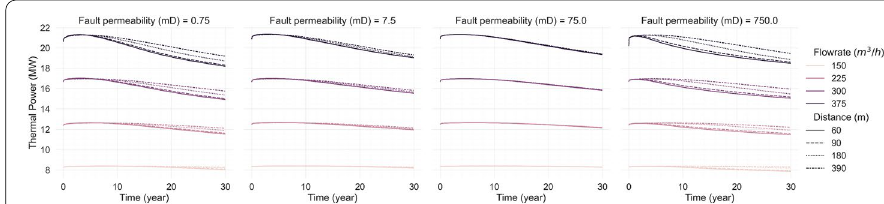
Fig. 6 Doublet power over time for fault permeability of 0.75 mD, 7.5 mD, 75 mD and 750 mD, FWD of 60 m, 90 m, 180 m and 360 m and injection temperature of 303.15 K